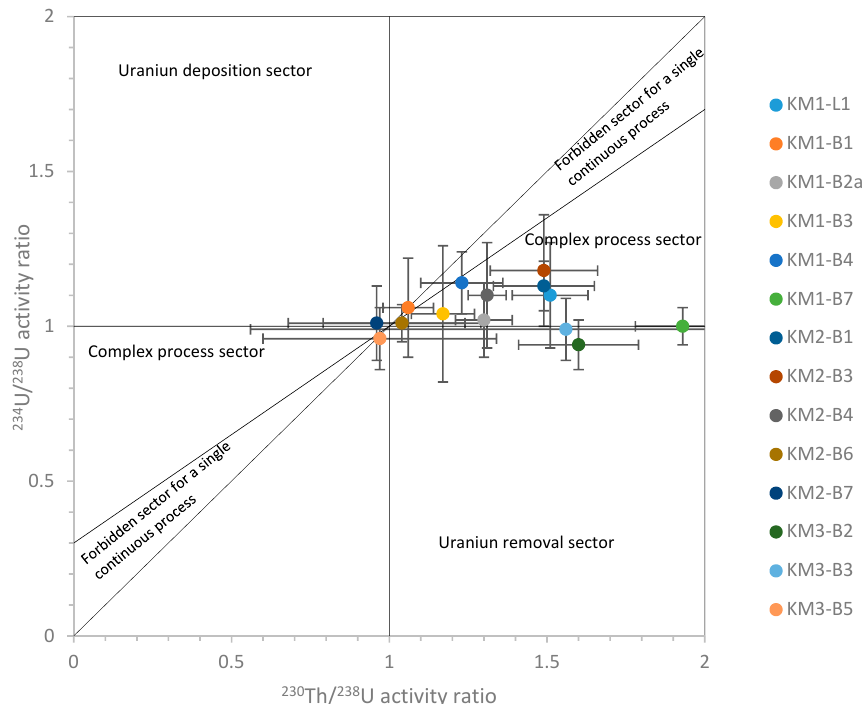
Figure 15. Plot of 234 U / 238 U activity ratio against 230 Th / 238 U activity ratio for samples from cores KM1, KM2 and KM3. NB 2 σ uncertainty limits are shown due to the increased confidence level (95% compared to 68% for 1 σ : see, for example, [61] for discussion).